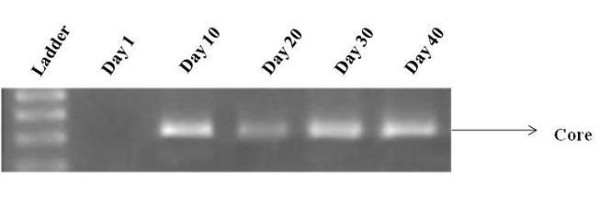
HCV core gene expressions in media supernatant. HCV core gene expressions in media supernatant; showed that HCV RNA was detected on the 10th day onward till 40th day post infection. HCV RNA was not detected from 1st to 9th day of post infection.